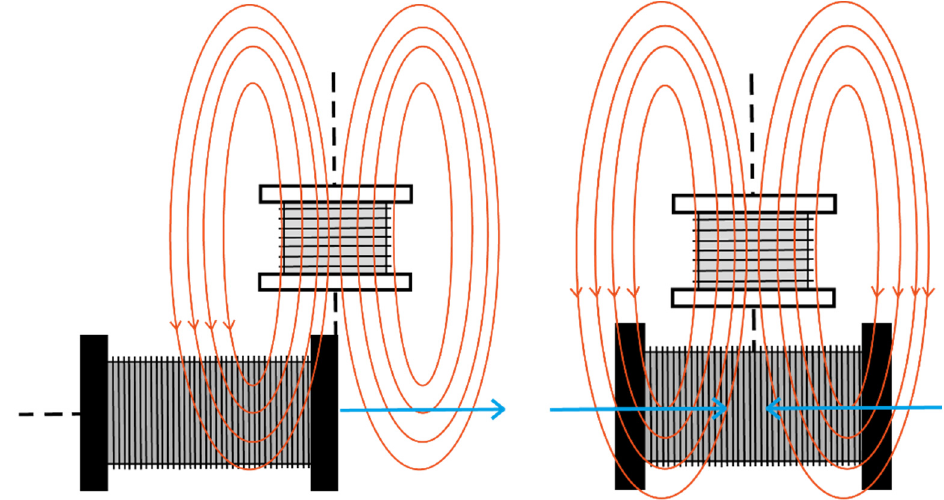
Figure 8. Induced voltage placing the secondary coil with its axial axis horizontal.